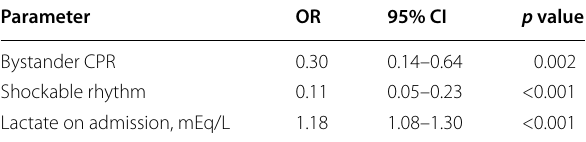
OR odds ratio, CI confidence interval, CPR cardiopulmonary resuscitation